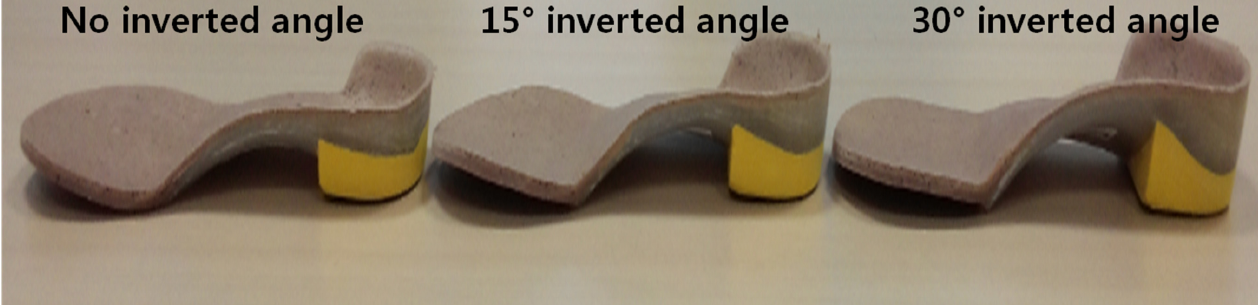
Fig 1. Medial view of the rigid foot orthoses. Left to right: (1) no inverted angle, (2) 15° inverted angle, (3) 30° inverted angle.